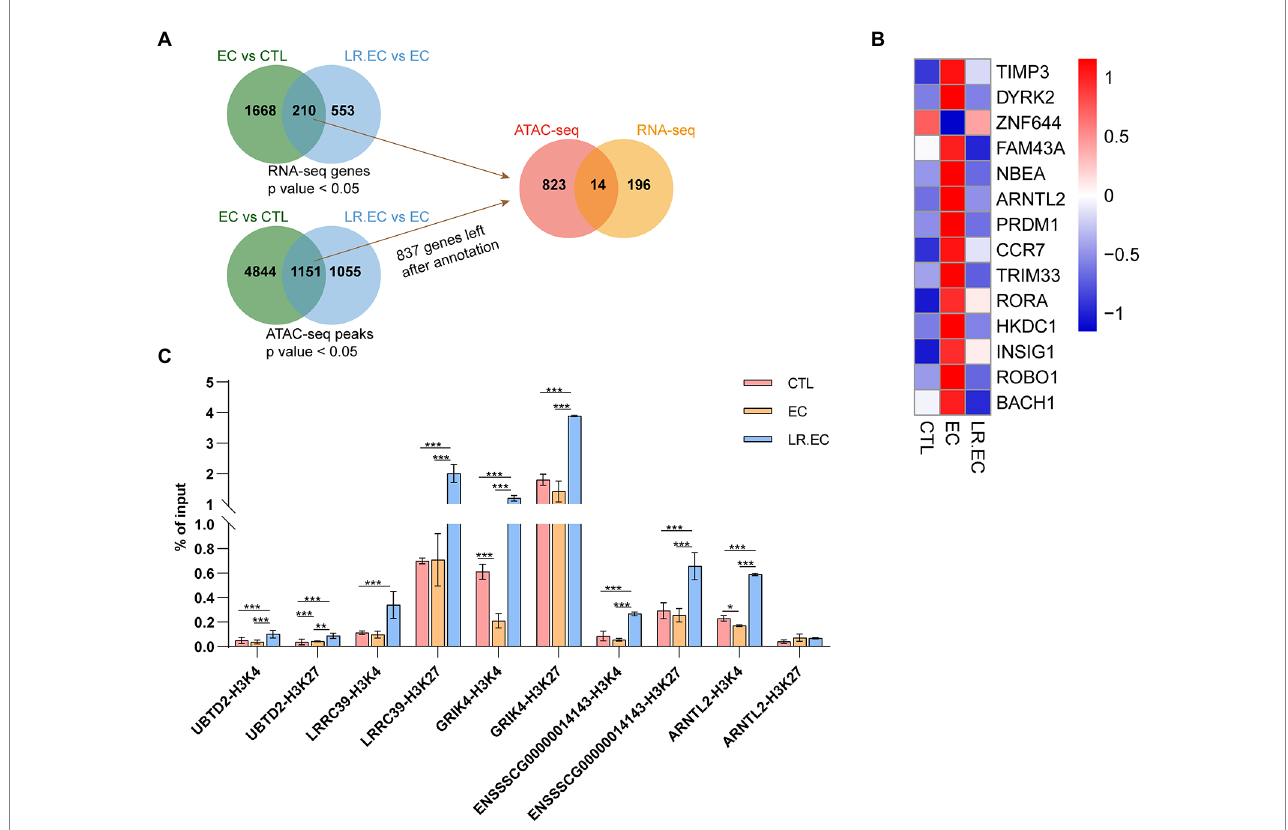
FIGURE 5 Integrative analysis of RNA-Seq and ATAC-Seq datasets. (A) Candidate gene were identified in two steps using overlap: the first step was overlap between different compared groups, and the second step was overlap between DEGs from RNA-seq dataset and annotated genes from ATAC-seq dataset. We set the threshold to a p value <0.05; we annotated ATAC-seq peaks to genomic features with the chipseeker package, and only 837 genes had gene names after annotation from DARs. (B) Heatmap of 14 overlapping genes in different groups. (C) Fold changes of histone H3K4me3 and H3K27ac were determined by ChIP-qPCR in chromatin accessible regions of UBTD2 , LRRC39 , GRIK4 , ENSSSCG00000014143 , and ARNTL2 . Data are shown as mean ± SD. * p < 0.05; ** p < 0.01; *** p <